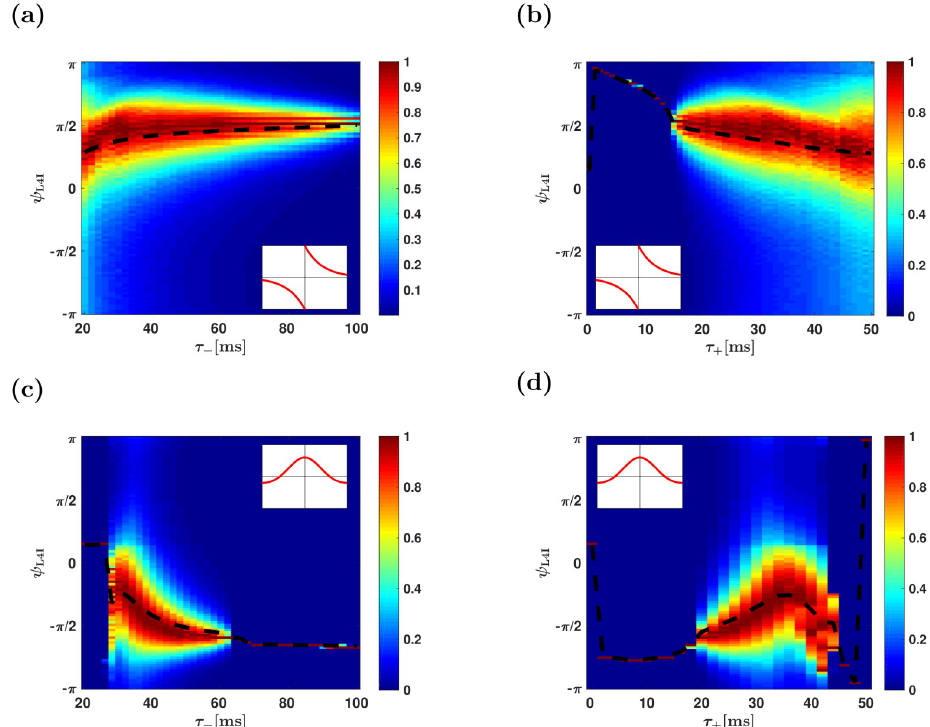
Fig 11. The effect of the temporal structure of the STDP rule. The distribution of preferred phases of L4I neurons, κ L4I , is shown as a function of the characteristic timescales of the STDP: τ − in (a) & (c) and τ − + in (b) & (d), for the temporally asymmetric rule in (a) & (b) and the symmetric rule in (c) & (d). The dashed black lines depict the mean phase. Unless stated otherwise, the parameters used here were: κ VPM = 1, γ = 1, D = 10hz, τ − = 50ms, τ + = 22ms, d = 10ms, ψ VPM = 5 π /6, μ = 0.01, α = 1.1 and λ = 0.01.